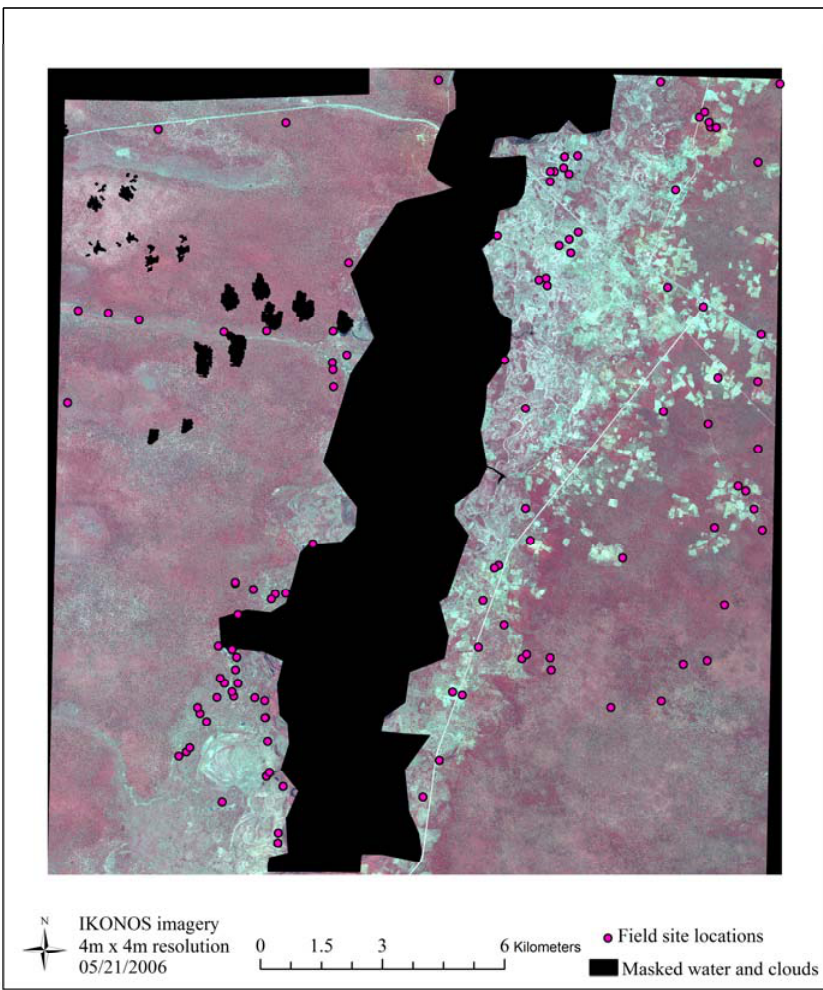
Figure 2. Distribution of field site locations within the focus region (as depicted in Figure 1) where vegetation transect and/or training sample data was collected, overlaid on the IKNOS image (color composite RGB = near infrared, red, green where red represents vegetation and cyan represents bare